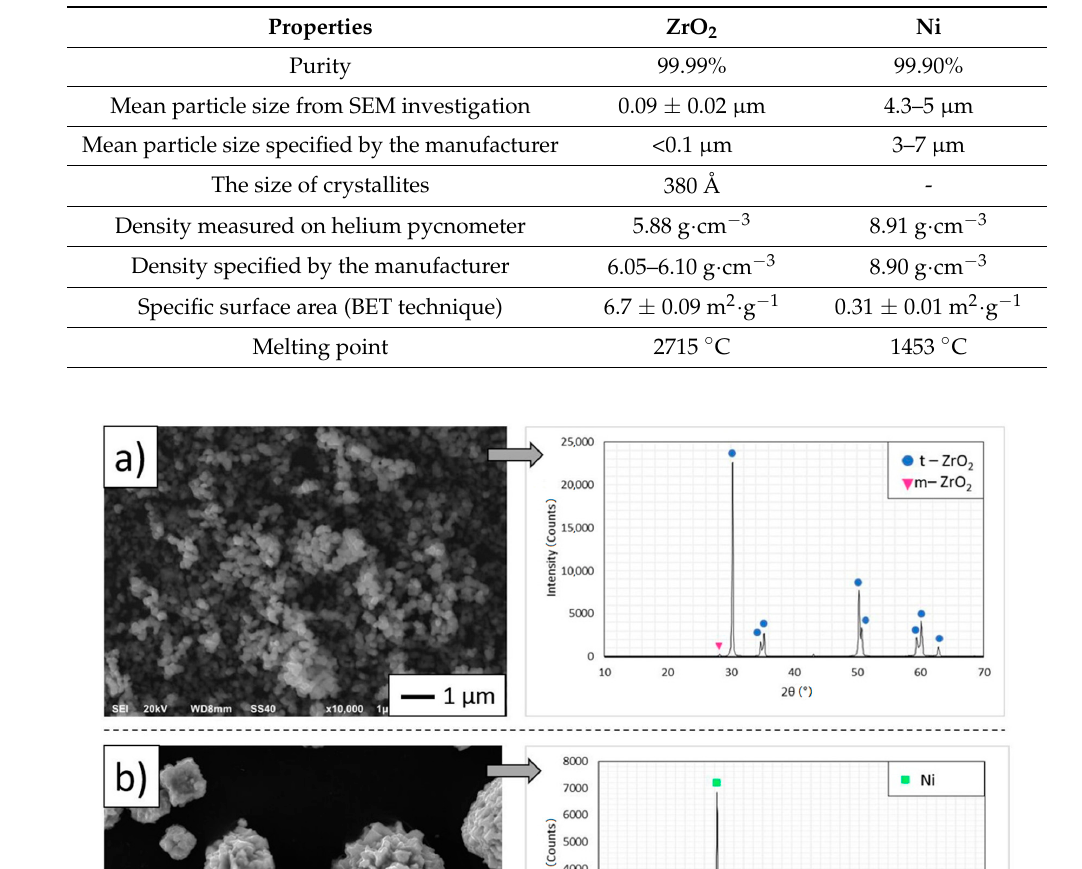
Table 1. Properties of the raw powders.